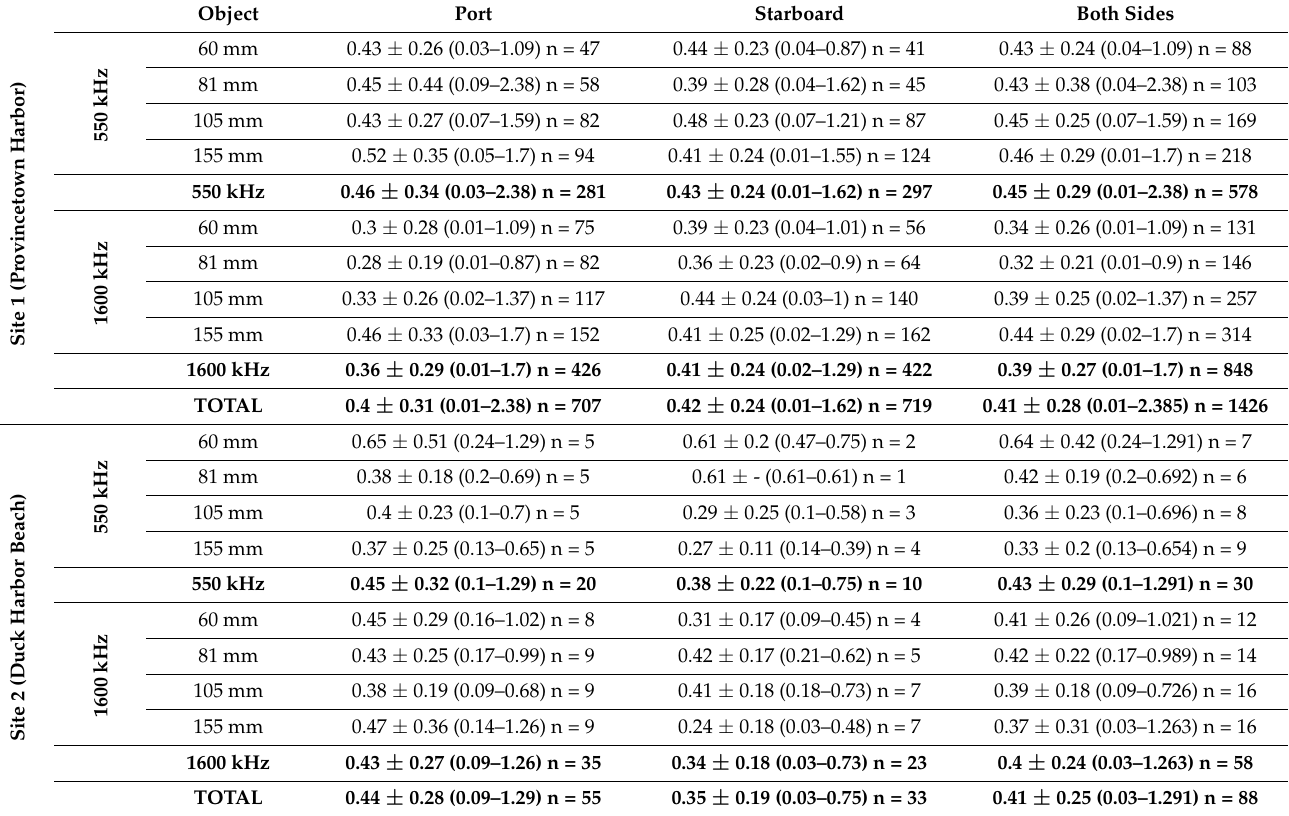
Table 3. Positional uncertainty. Summary statistics for Site 1 (Provincetown Harbor) and Site 2 (Duck Harbor beach) surveys. Data for each object (mean ± standard deviation (min–max)) for both port and starboard and each frequency are indicated. Unless otherwise specified, units are in